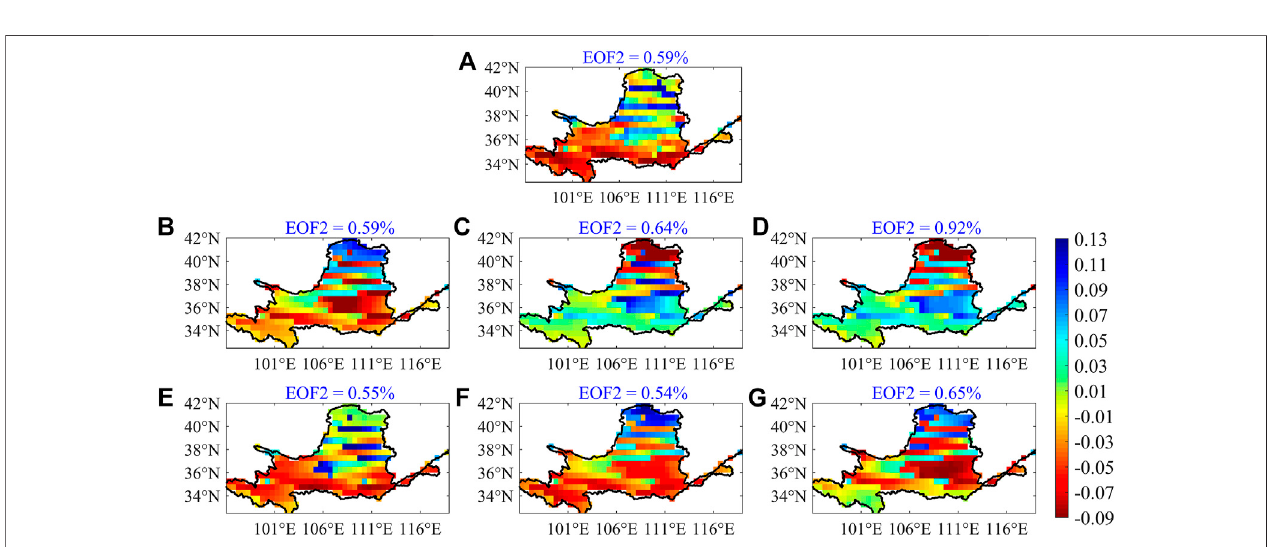
Frontiers in Earth Science |